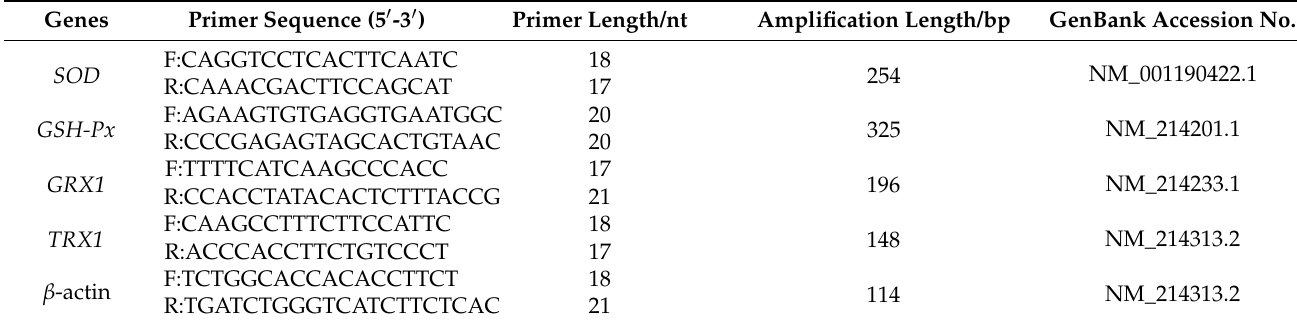
Table 2. Information on primers used for